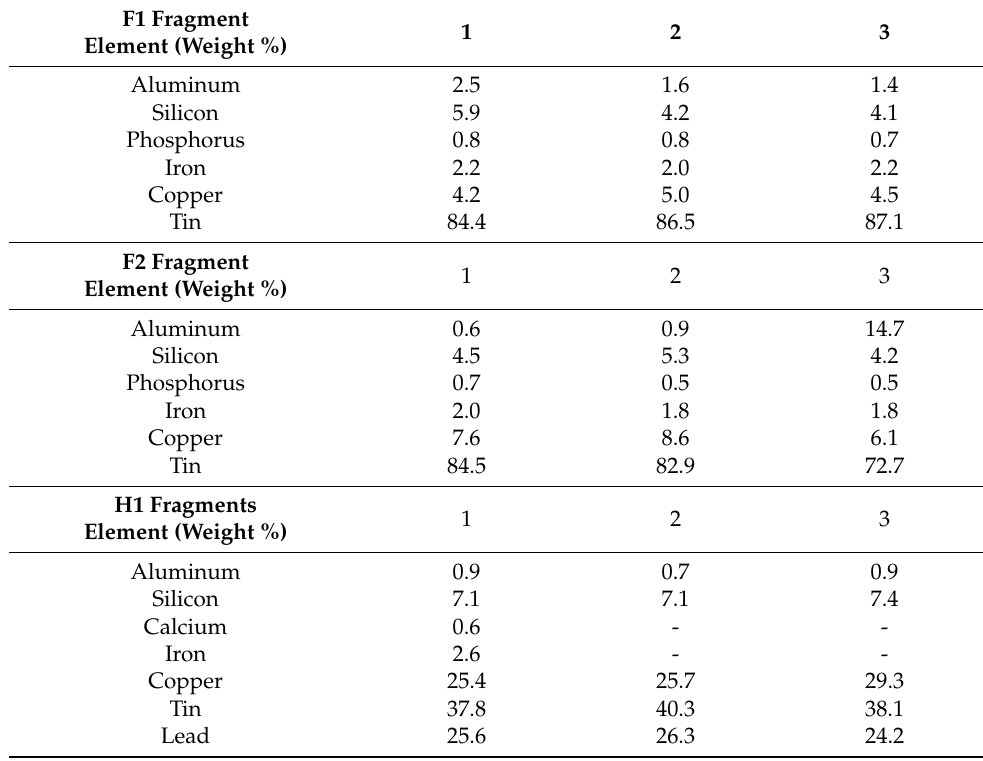
Table 2. Semi-quantitative analyses by SEM-EDS on the metal fragment surface.